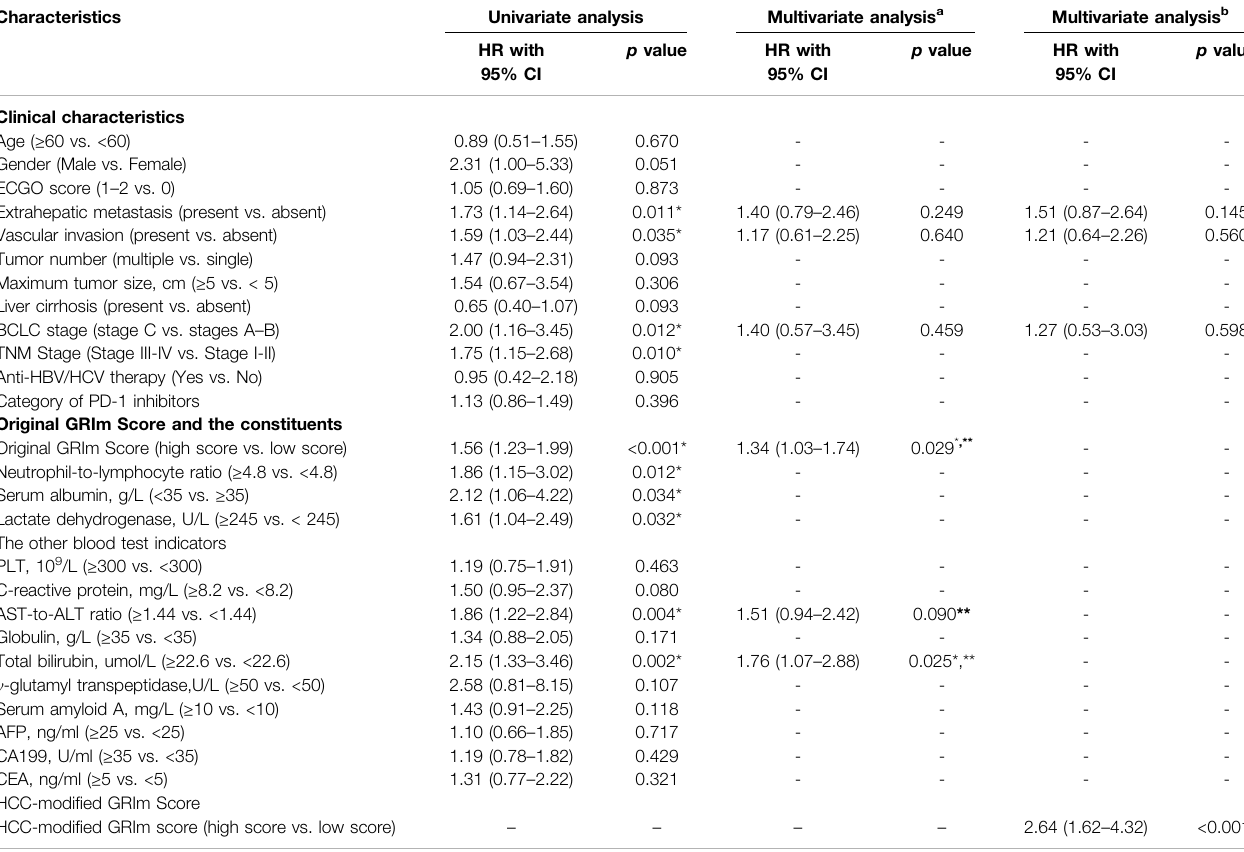
TABLE 1 | Univariate and multivariate Cox regression analyses of predictive factors for overall survival in training group.